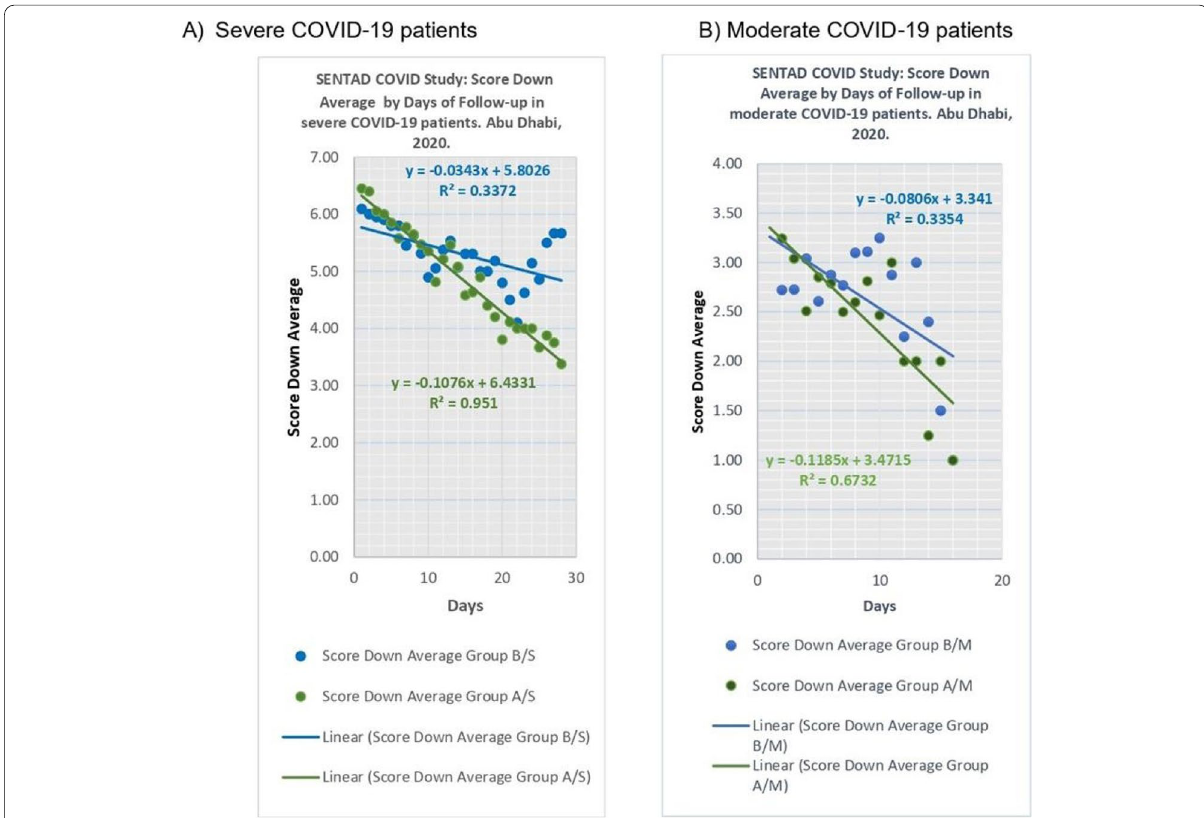
Fig. 4 Clinical improvement. Different trend line slopes during the clinical trial follow‑up. Legend: Group A/S: Peripheral Blood Non‑Hematopoietic Enriched Stem Cell Cocktail (PB‑ NHESC‑C) Treated classified as severe; Group B/S: Controls classified as severe; Group A/M: PB‑NHESC‑C Treated classified as moderate; Group B/M: Controls classified as moderate